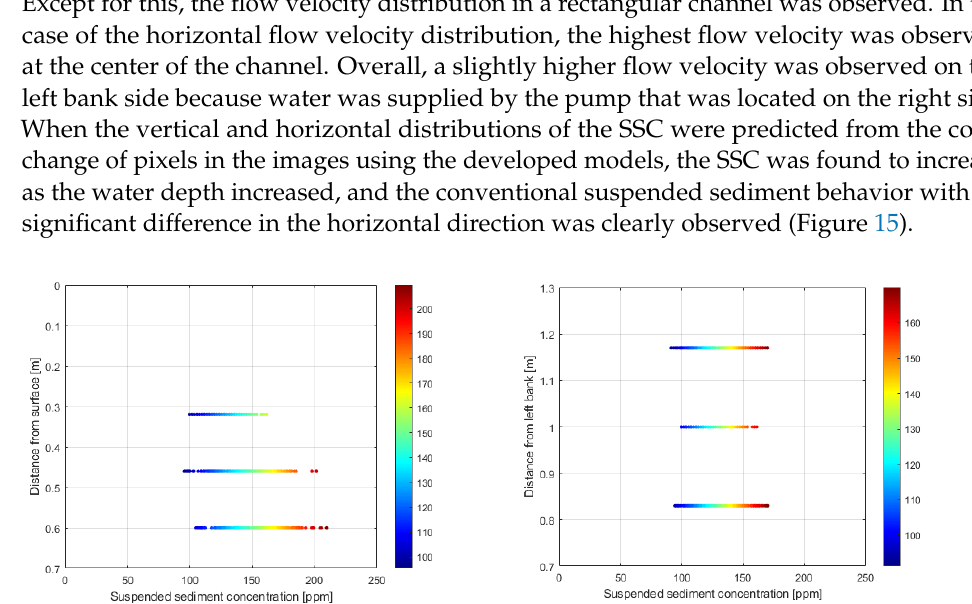
Figure 15. Predicted suspended sediment concentration of ( a ) vertical distribution, and ( b ) horizon- tal distribution.